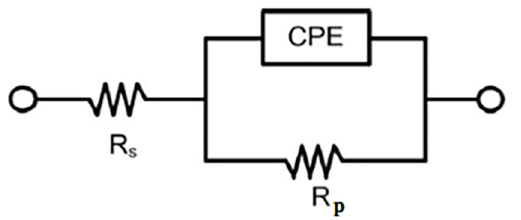
Figure 6. Electrical equivalent circuit used to fit the Bode phase diagrams